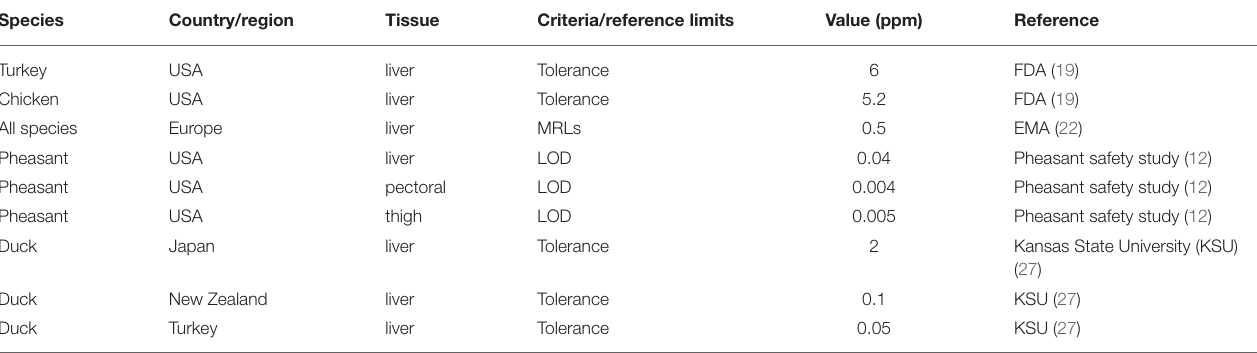
MRL, maximum residue limit; LOD, Limit of